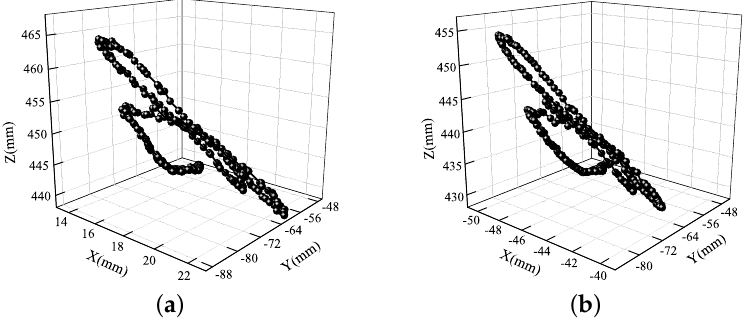
Figure 16. 3D eye trajectories during driving over speed bumps: ( a ) left eye; ( b ) right